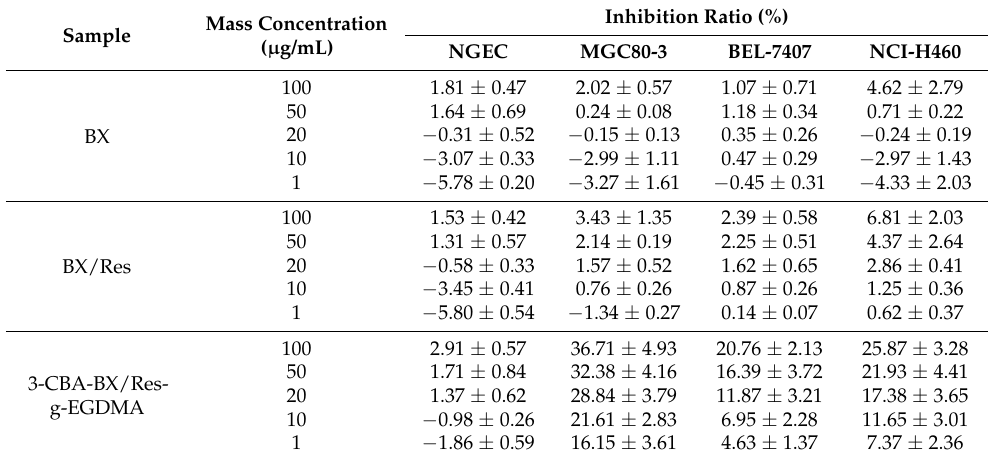
Table 2. The inhibition ratio of BX, BX/Res and 3-CBA-BX/Res-g-EGDMA on different cancer cells and normal cells.